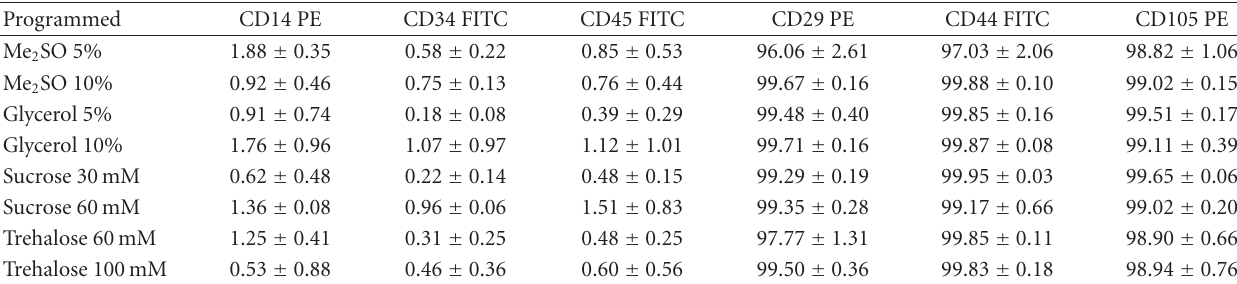
Figure 6: AFSCs were thawed, total RNA was extracted, and Oct-4 and Nanog gene expression was determined by RT-PCR in 2% agarose gel stained with ethidium bromide after freezing with di ff erent cryoprotectants. Human β -actin was used as endogenous control. MW: 100bp molecular weight; A: 5% Me 2 SO nonprogrammed; B: 5% Me 2 SO, programmed; C: 10% Me 2 SO, nonprogrammed; D: 10% Me 2 SO, programmed; E: 5% Glycerol, nonprogrammed; F: 5% Glycerol, programmed; G: 10% Glycerol, nonprogrammed; H: 10% Glycerol, programmed; I: 30mM Sucrose, nonprogrammed; J: 30mM Sucrose, programmed; K: 60 mM Sucrose, nonprogrammed; L: 60 mM Sucrose, programmed; M: 60 mM Trehalose, nonprogrammed; N: 60 mM Trehalose, programmed; O: 100 mM Trehalose, nonprogrammed; P: 100mM Trehalose; programmed; Q: positive control (Ntera-2.c1D1 cell line). Table 3: After programmed freezing, AFSCs ( n = 5) maintained their specific mesenchymal membrane proteins evaluated by flow cytometry (CD29, CD44, and CD105 positive; CD14, CD34, and CD45 negative). The number of acquired events was 15,000 in each acquisition. Results are shown as percentage ±